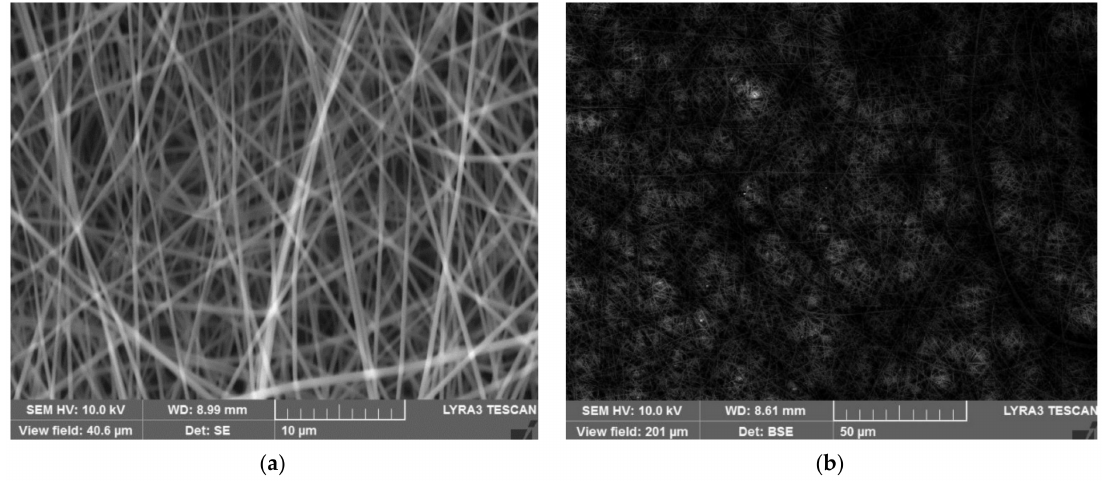
Figure 7. Scanning electron microscopy of nanofibrous patch: ( a ) higher magnification; ( b ) lower